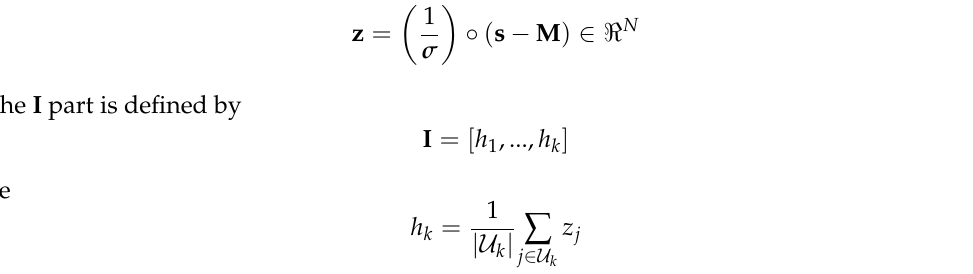
Figure 1 is an example of computing I part using 4 IIR masks from testing images.